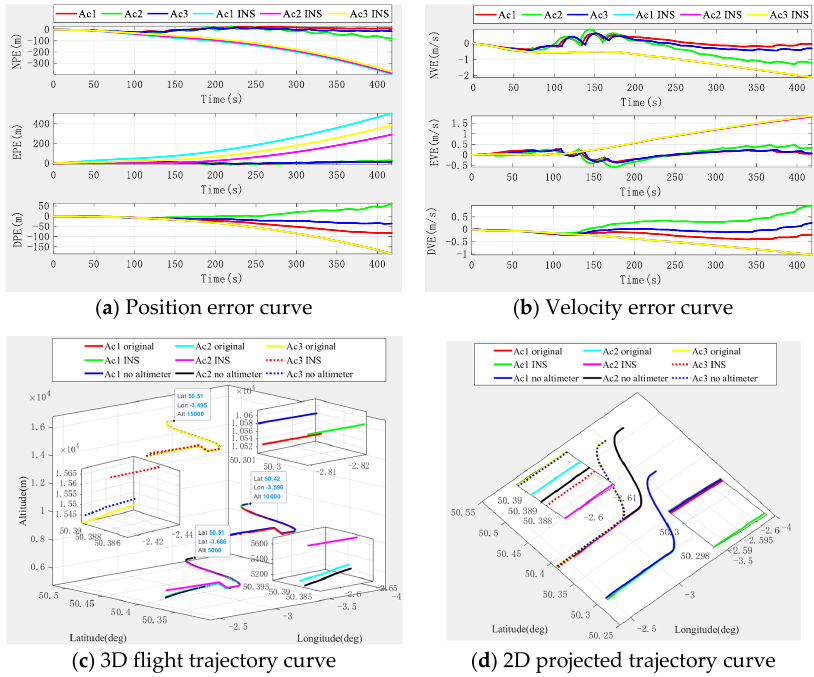
Figure 6. Navigation and positioning error curve of multi-aircraft cooperative navigation in the DWAPC-TSM system without altimeter assistance.